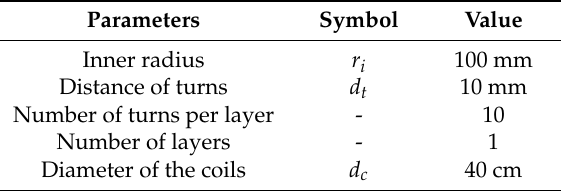
Table 1. Parameters of a practical coil.